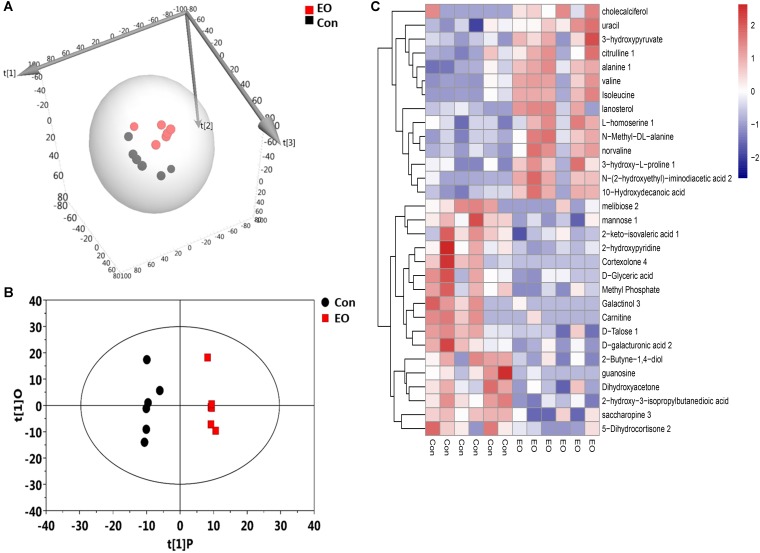
3D-PCA score map, OPLS-DA score plots, and hierarchical clustering heat map derived from the GC-TOF/MS metabolic profiles in the colon of weaned piglets fed with or without dietary EO. (A) 3D-PCA score map showed the distribution of origin data. (B) OPLS-DA score plots showed significantly separated clusters between EO and Con group. Black represented Con group and red represented EO group. (C) Hierarchical clustering heat map constructed using molecular features with 1-fold changes (P < 0.05) showed a consistent clustering pattern within individual groups. Con: the basal diet; EO: the basal diet supplemented with essential oils.